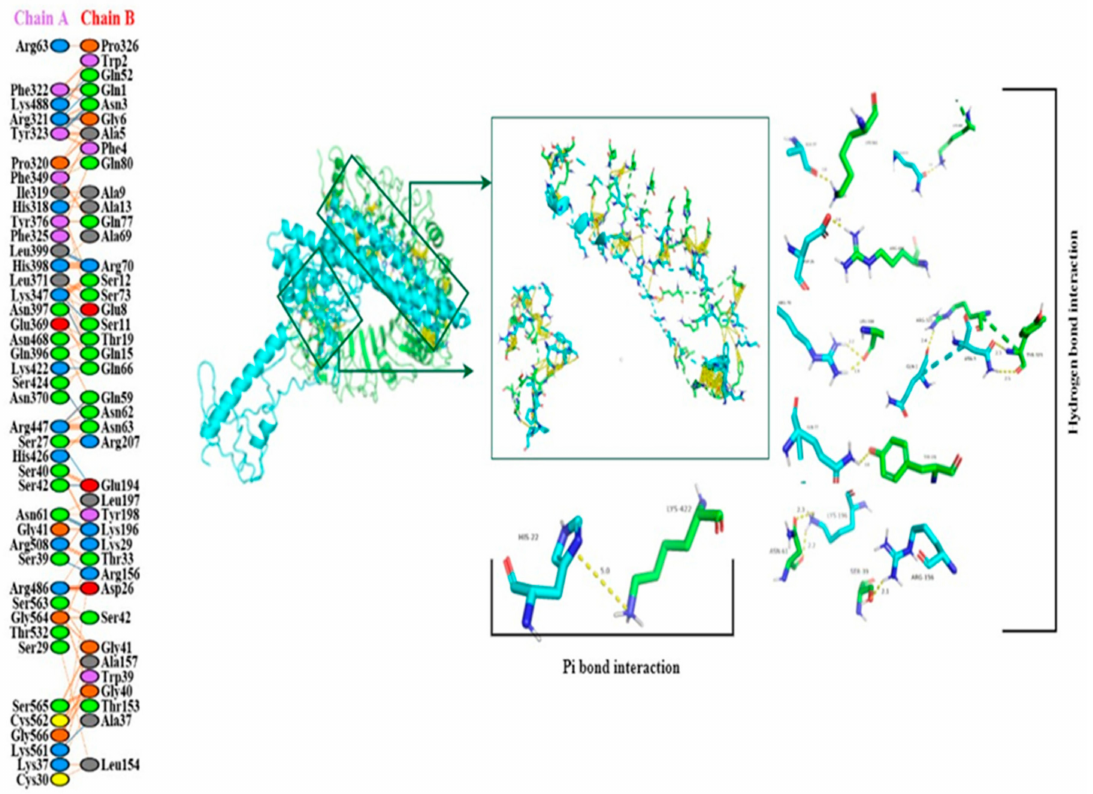
Figure 9. The figure shows the binding interaction between active residues of a docked complex of human TLR-2 and vaccine construct. Chain A represents active residues of TLR-2, while chain B represents active residues of the vaccine construct.